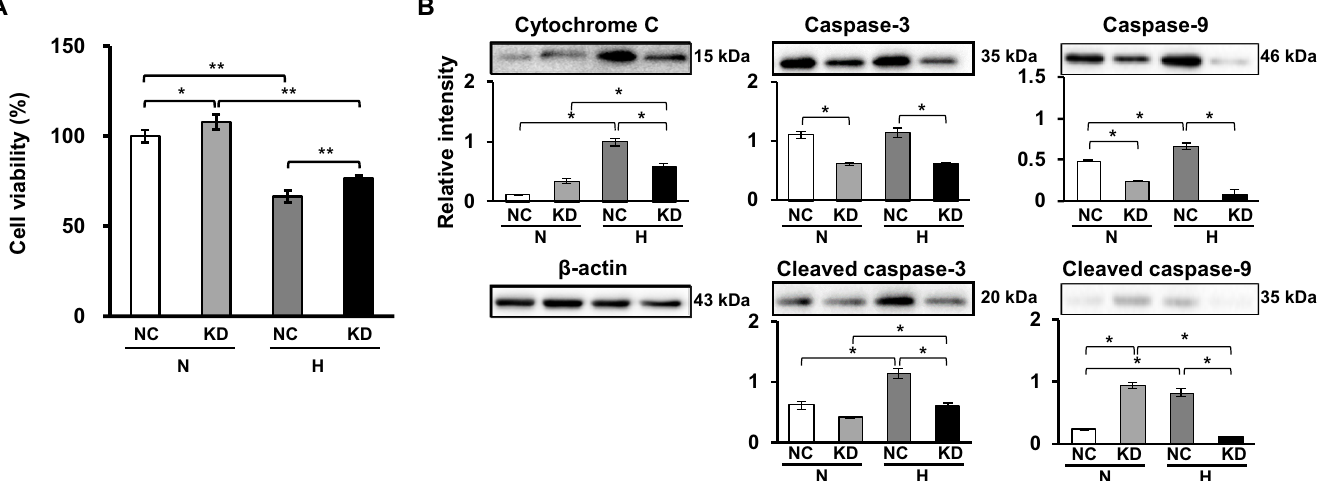
Fig 3. Effects of Sgsm3 knockdown on cell death and apoptosis under hypoxia in rat MSCs. Changes in cell viability (A) and apoptosis marker expression (B) in MSCs with Sgsm3 knockdown under normoxic and hypoxic conditions were measured using Ez-Cytox and immunoblot analysis, respectively. Band intensity was measured as the area density and analyzed in ImageJ and relative intensity levels indicate protein levels normalized to the β -actin levels. The data are representative of two independent experiments. Significant differences between groups were determined via ANOVA, with p values indicated as � p < 0.05 and �� p < 0.01. N, normoxia; H, hypoxia; NC, negative control cells; KD, knockdown